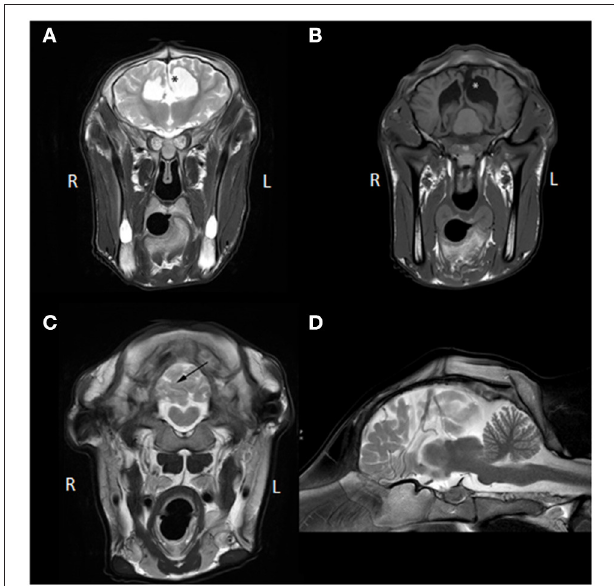
FIGURE 1 | (A) Transverse T2W MR images at the level of the third ventricle, (B) transverse T1W MR images at the level of the caudal aspect of the lateral ventricles and rostral colliculi of the mesencephalon, (C) transverse T2W MRI image at the caudal aspect of the cerebellum, (D) mid-sagittal T2W MR image. The asterisk (*) in (A,B) demarcates the communication between the left lateral ventricle and the subarachnoid space and represents the porencephaly. Also, in (A) , communication between the left lateral and right lateral ventricle is visible due to partial absence of the septum pellucidum and no corpus callosum is identifiable. In (B) , fusion of the rostral colliculi is appreciated. In (C) , the black arrow points toward the irregular and apparently incomplete separation between right and left cerebellar hemisphere (not confirmed on post-mortem examination; likely represents in situ displacement). Partial herniation of the left hemisphere over the midline into the right hemisphere is visible (not confirmed on post-mortem examination; likely represents in situ displacement). In (D) , the corpus callosum and mesencephalic aqueduct are hard to identify and increased fluid signal between cerebral gyri and cerebellar folia is seen, which can also be appreciated in (A–C)